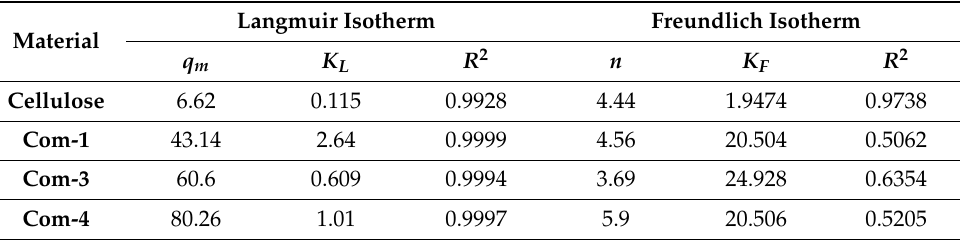
Figure 11. Adsorption isotherms of ( a ) cellulose treated with chitosan (Com-3), and ( b ) cellulose treated with chitosan pyridine (Com-4). Inserts show the experimental data fitted to the isothermal Langmuir model. Table 3. Constants and correlation coefficients for Langmuir and Freundlich Isotherms.